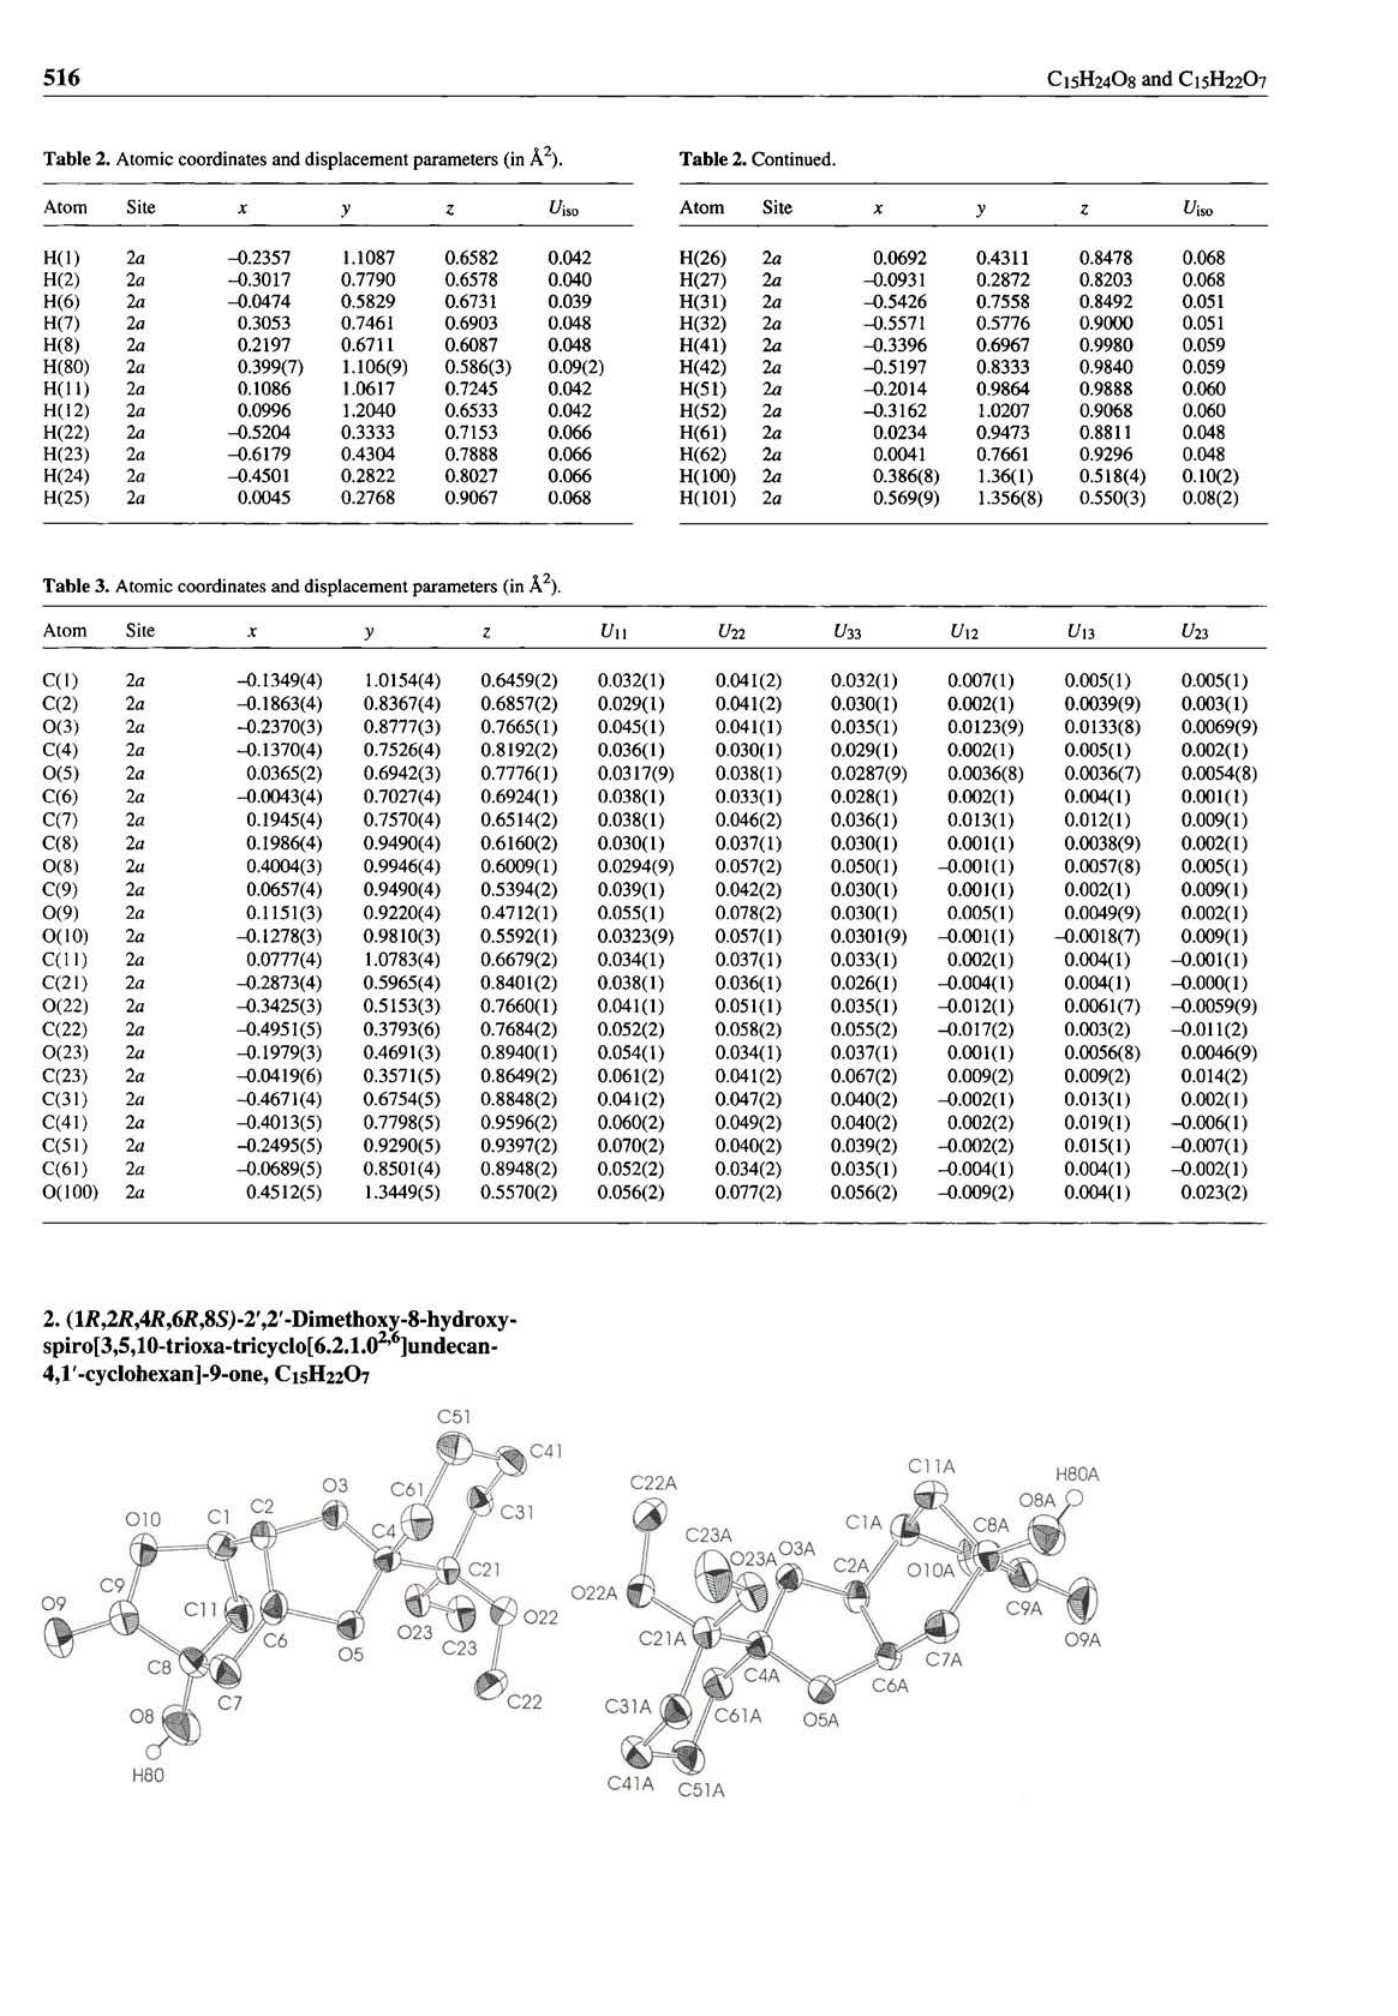
Table 3. Atomic coordinates and displacement parameters (in A 2